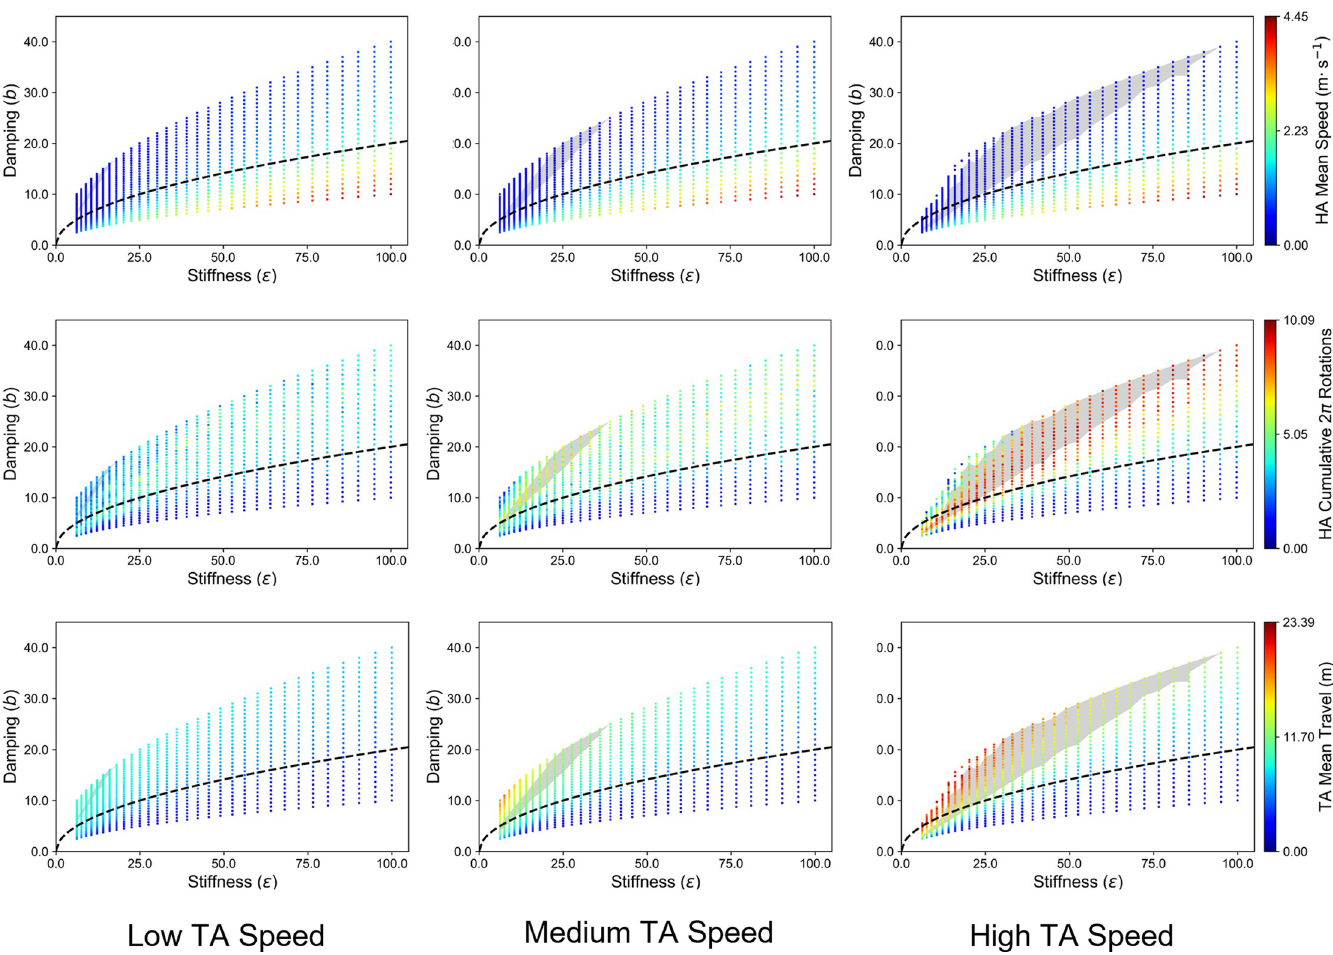
Fig 6. Relationship between human and artificial herding agent (HA) behavior at different task difficulty conditions. The colored scatterplots on all nine figures represent the data points associated with the combinations of stiffness ( ε ) and damping ( b ) values used in the HA simulations (see main text). The black dotted line running through each of these figures represents critical damping, i.e., those parameter values that satisfy the condition where b ¼ 2 constant value of 1 kg. Parameters above/below the line indicate a system that is over/under-damped. The color coding of data points is defined according to mean movement speed of the HAs (top row), number of cumulative 2π rotations by the HAs (middle row), and mean distance traveled (i.e., path length) by the target agents (TAs; bottom row). From left to right, figure columns represent simulations at three increasing levels of task difficulty according to correspondingly increasing levels of assigned TA speeds: Low-speed ( � 0.12 m � s -1 ; left column), medium-speed ( � 0.20 m � s -1 ; middle column), and high-speed ( � 0.28 m � s -1 ; right column). Different combinations of stiffness and damping resulted in differences in the qualitative behaviors adopted by the artificial HAs (middle row), as well as in the HAs’ ability to contain the TAs (bottom row). The gray areas in all figures designate the regions of b- ε parameter space that fall within the 95% confidence interval of human locomotion speeds in these difficulty condition (constructed using HA Mean Speed [top row]). See also S1 Fig